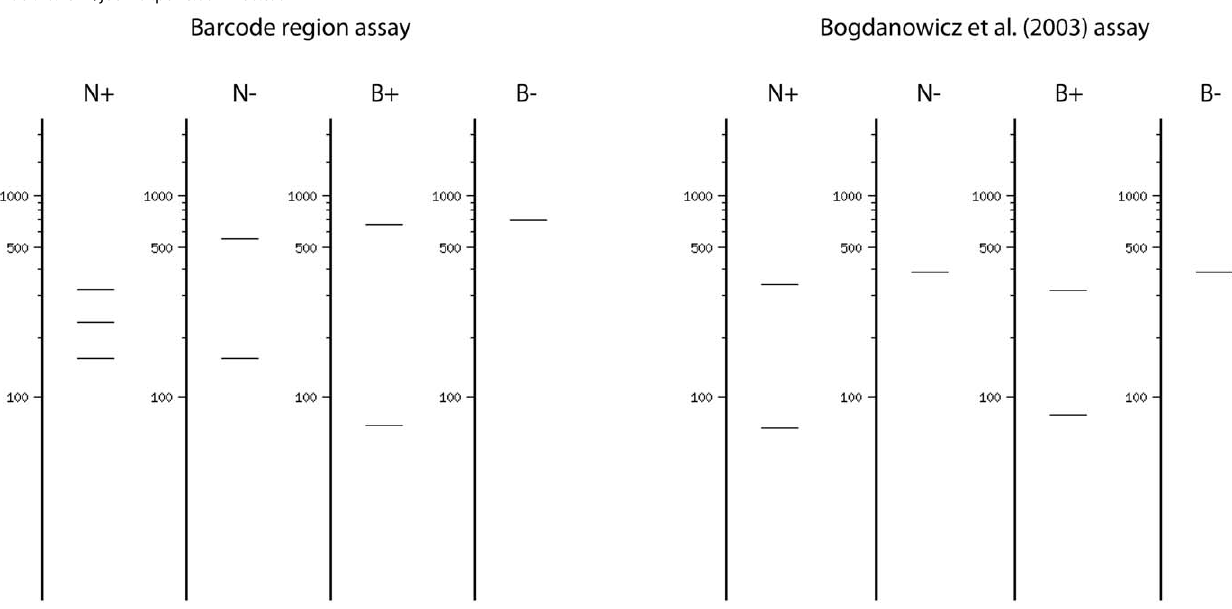
Figure 6. Simulated gel electrophoresis for two restriction fragment length polymorphism assays. The barcode region assay amplifies a , 690 bp fragment, whereas the Bogdanowicz et al [24] assay amplifies , 380 bp. The presence ( + ) or absence ( 2 ) of the NlaIII and BamHI restriction sites are provided for each assay, as described in the text. The digest and electrophoresis simulations were performed with New England BioLabs NEBcutter V2.0 (http://tools.neb.com/NEBcutter2). doi:10.1371/journal.pone.0014280.g006 PLoS ONE |